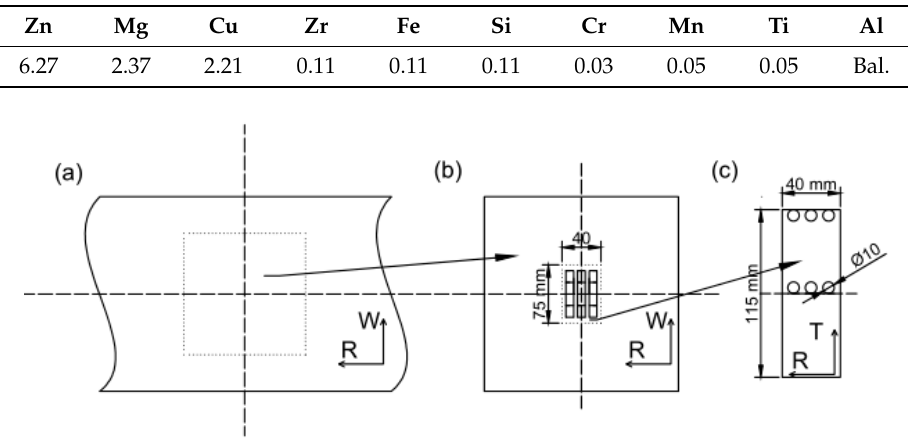
Table 1. Chemical composition of 7050 aluminum alloy (wt.%).